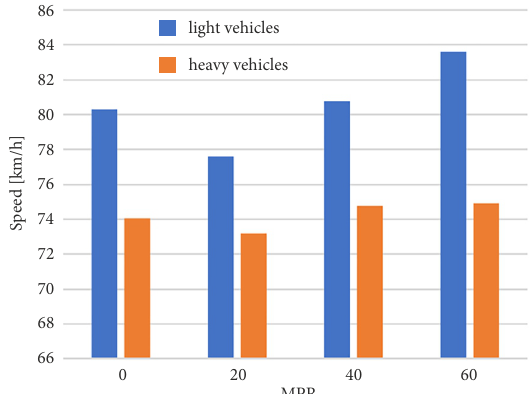
Figure 13. Speed of light vehicles (blue) and of heavy vehicles (orange) for different MPRs [km/h] – dissolution strategy